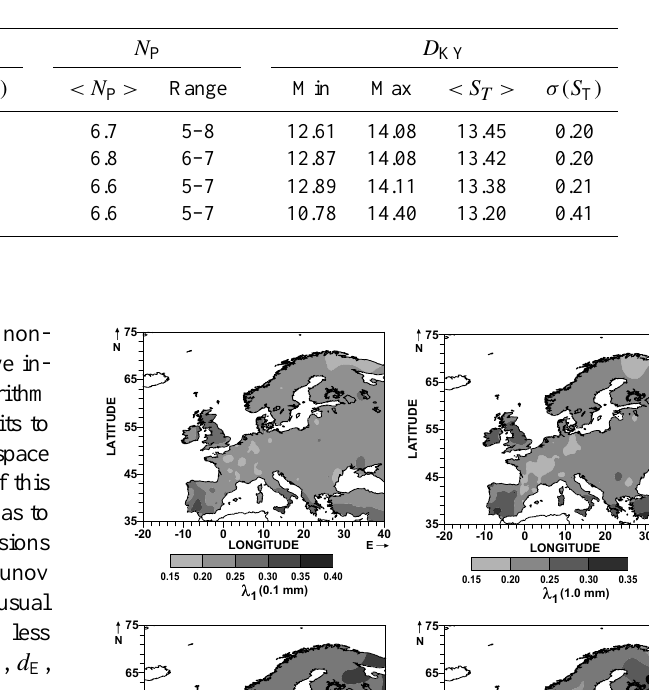
sion, close to 13.5 and hardly ever exceeding 14.0. The dis- sipative and notable chaotic behaviour of the DSL series is confirmed by the average number, < N P > , of positive Lya- punov exponents for the four thresholds R 0 , ranging from 6.6 to 6.8, in comparison with the maximum reconstructed dimension ( m = 15) used to obtain stationary values of the Lyapunov exponents. Both characteristics, as the D KY di- mension, depict a low spatial variety, as the maximum range of N P (5–8) is detected for 0.1 mm/day and the minimum (6–7) for 1.0 mm/day. Then, in spite of the spatial variabil- ity of the other parameters of the reconstruction analyses, a common feature of the dynamical system governing Euro- pean DSLs is a structure of strange attractors with fractal di- mensions within a narrow range (12.6–14.1), except for the threshold of 10.0 mm/day, for which strange attractors with dimensions below 11.0 are